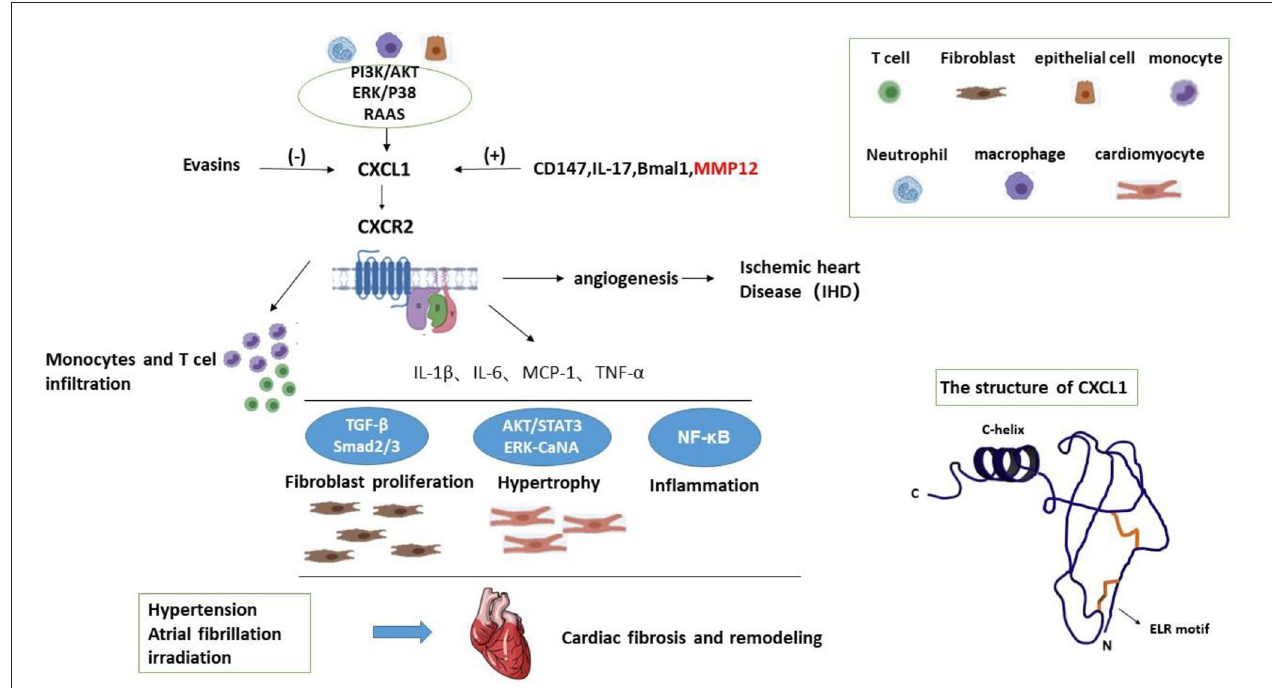
FIGURE 1 | The structure of CXCL1 and working model for the mechanisms of CXCL1 in cardiac